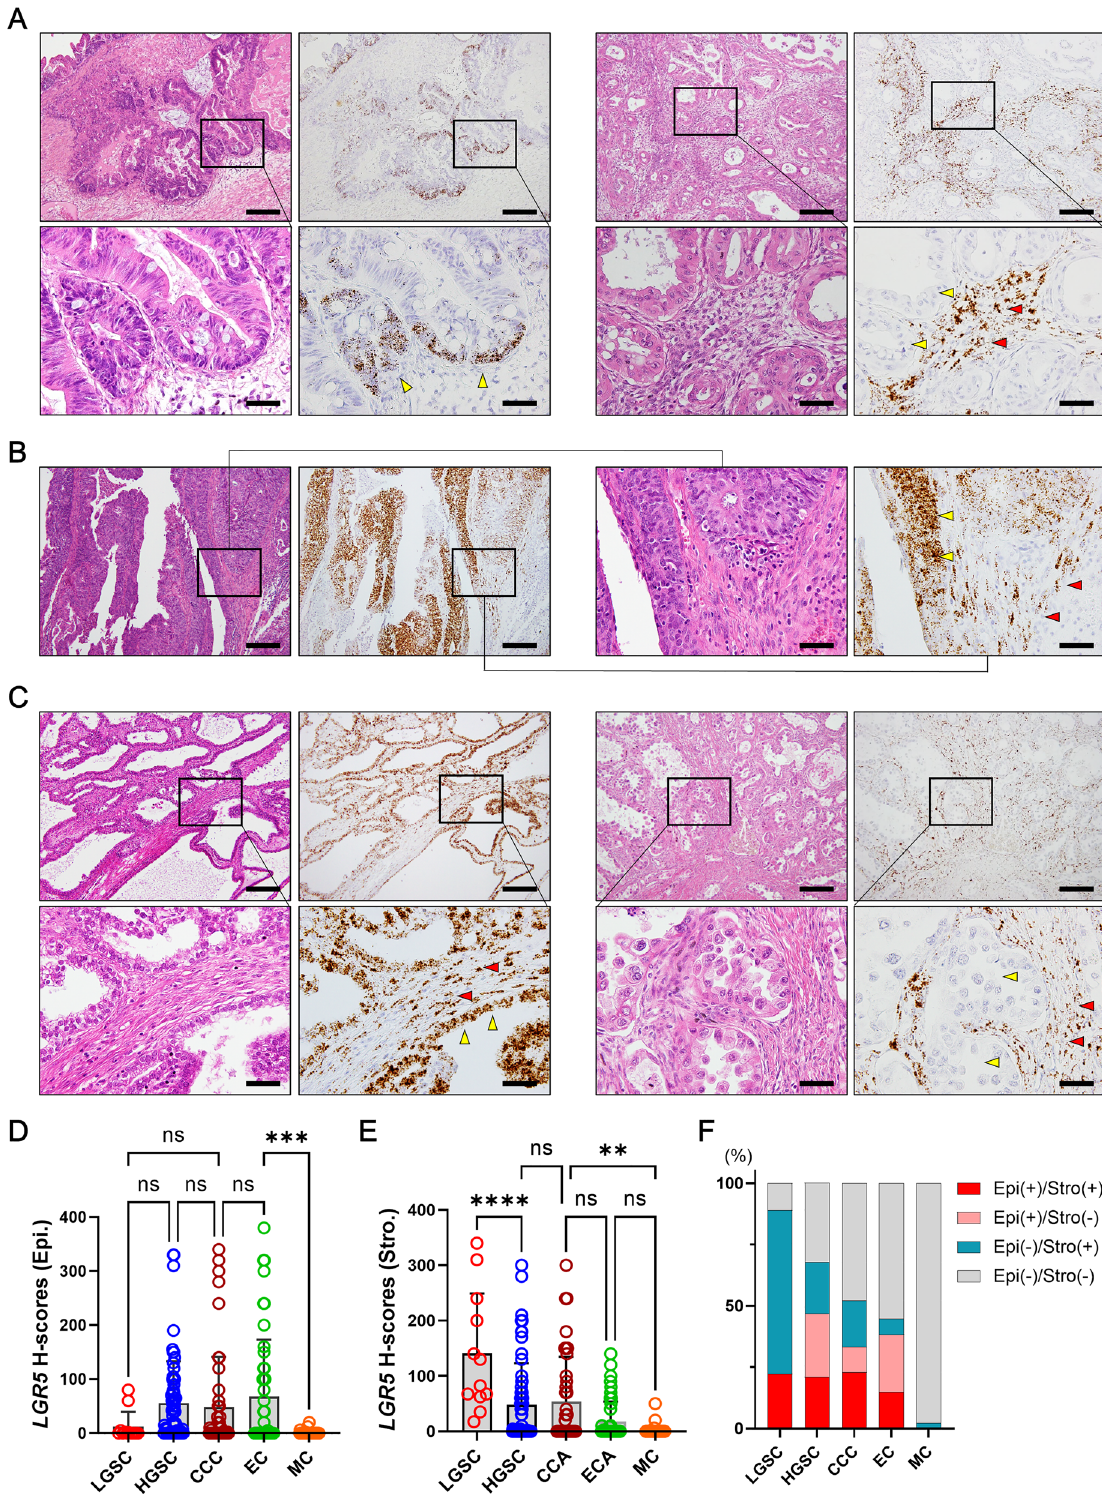
Figure 8. LGR5 expression in various histological subtypes of ovarian carcinomas. Representative images of LGR5 expression in mucinous carcinoma (MC, n = 44) ( A ), endometrioid carcinoma (EC, n = 47) ( B ), and clear cell carcinomas (CCC, n = 48) ( C ). Scatter plots showing histo-scores (H-scores) of epithelial ( D ) or stromal ( E ) LGR5 expression in each subtype of ovarian carcinoma. ( F ) A bar graph showing the proportions of epithelial and stromal LGR5 positivity in each subtype of ovarian carcinomas with an H-score cutoff value of 40. Low- grade serous carcinoma (LGSC, n = 12), High-grade serous carcinoma (HGSC, n = 64). Scale bar, 0.2 mm (left two panels) and 50 µm (right two panels) ( A , C ); 0.2 mm (upper panels) and 50 µm (lower panels) ( B ). ns not significant. ** P < 0.01, *** P < 0.001, **** P < 0.0001 by Tukey’s multiple comparisons